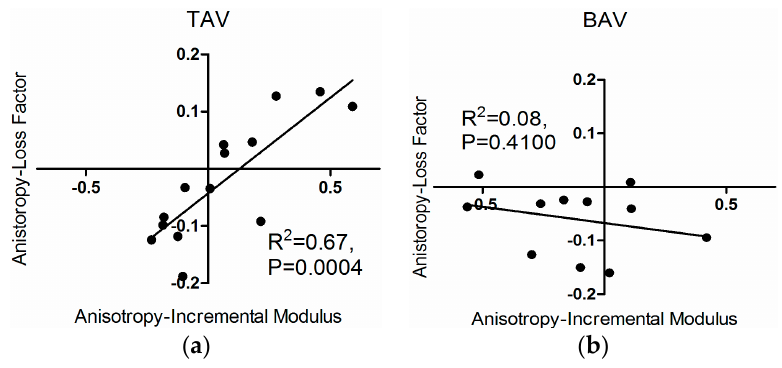
Figure 8. Loss factor anisotropy with respect to incremental modulus anisotropy for ( a ) the TAV; and ( b ) the BAV group.